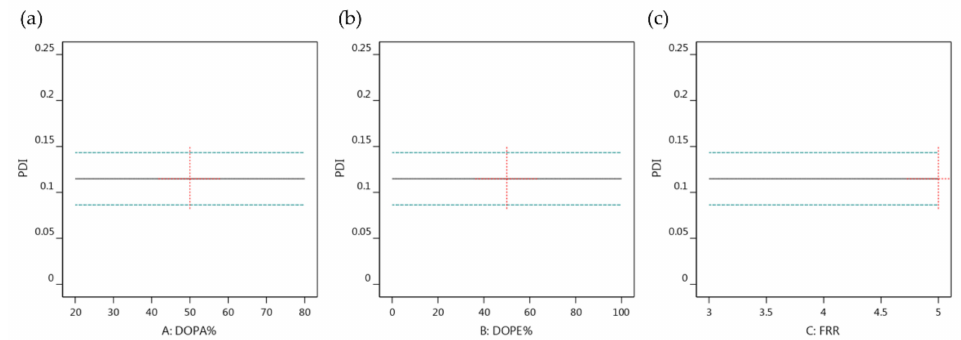
Figure 7. One-factor effect of ( a ) amount of DOPA, ( b ) amount of DOPE and ( c ) FRR on particle